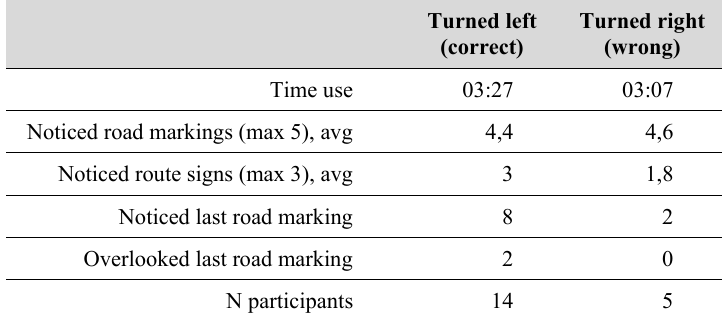
Table 2 Characteristics of left and right turning cyclists Turned left Turned right (correct) (wrong) Time use 03:27 03:07 Noticed road markings (max 5), avg 4,4 4,6 Noticed route signs (max 3), avg 3 1,8 Noticed last road marking 8 2 Overlooked last road marking 2 0 N participants 14